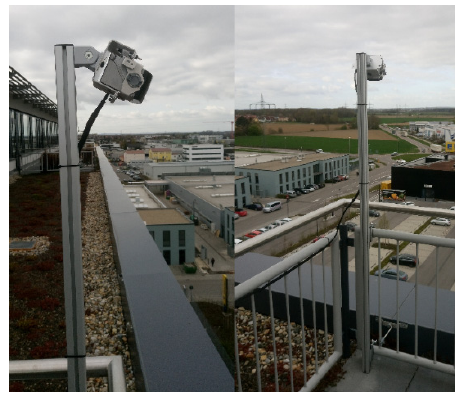
Figure A1. Measurement setup showing the placement of the LIDAR sensor. The location was chosen to avoid the influence of dust caused by cars and local weather variations caused by nearby high buildings or other structures.